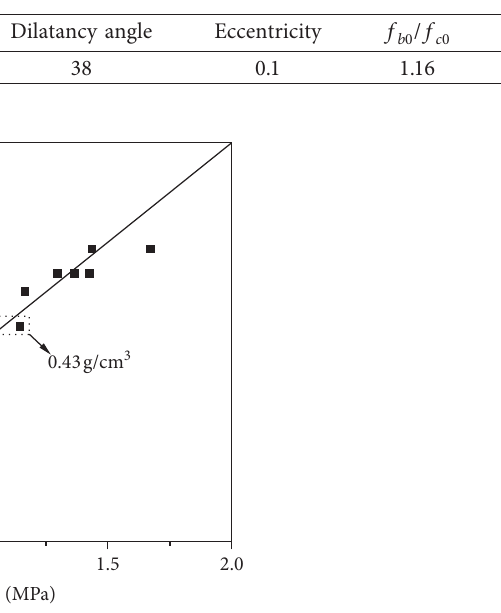
Table 3: Model parameters.